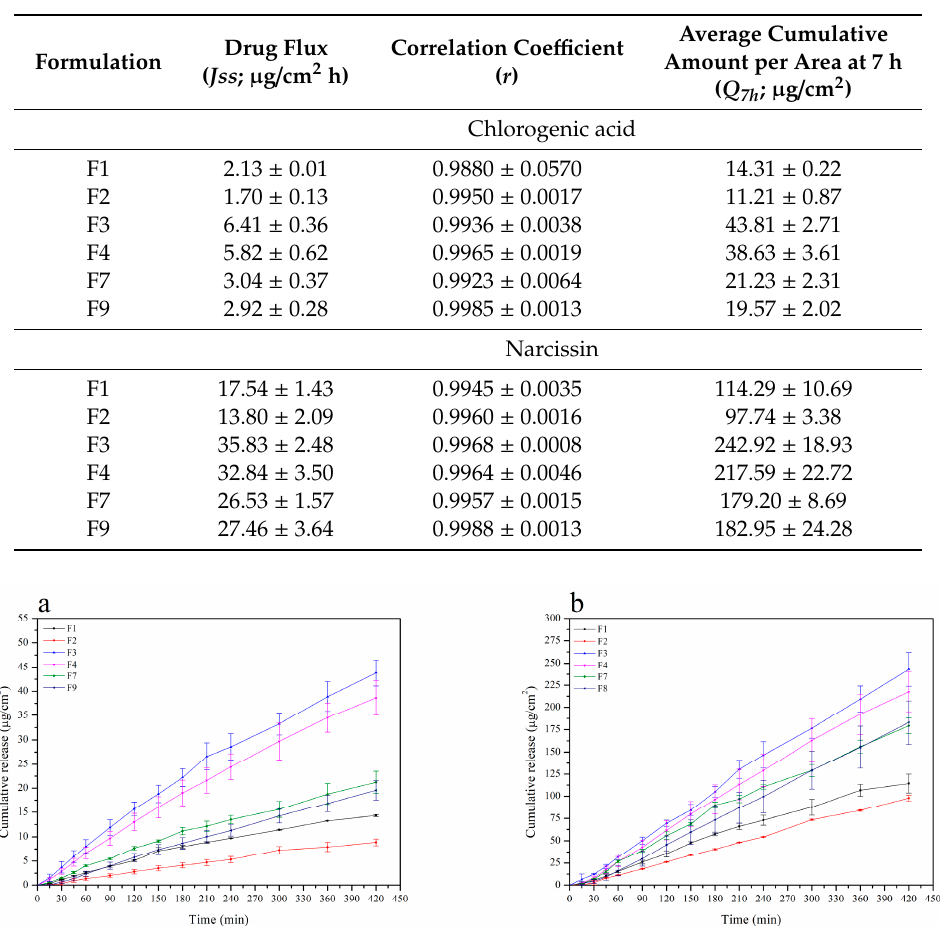
Figure 7. Dissolution profiles of chlorogenic acid ( a ) and narcissin ( b ) from HPMC-based hydrogel with chitosan delivery system with Calendulae flos lyophilized extract at pH = 5.5, where F1—2% HPMC-based hydrogel with 3% of Calendulae flos lyophilized extract, F2—3% HPMC-based hydrogel with 3% of Calendulae flos lyophilized extract, F3—2% HPMC-based hydrogel with 10% of Calendulae flos lyophilized extract, F4—3% HPMC-based hydrogel with 10% of Calendulae flos lyophilized extract, F7—2% HPMC-based hydrogel with 10% of Calendulae flos lyophilized extract + chitosan 80/500, and F9—2% HPMC-based hydrogel with 10% of Calendulae flos lyophilized extract + chitosan 80/1000.